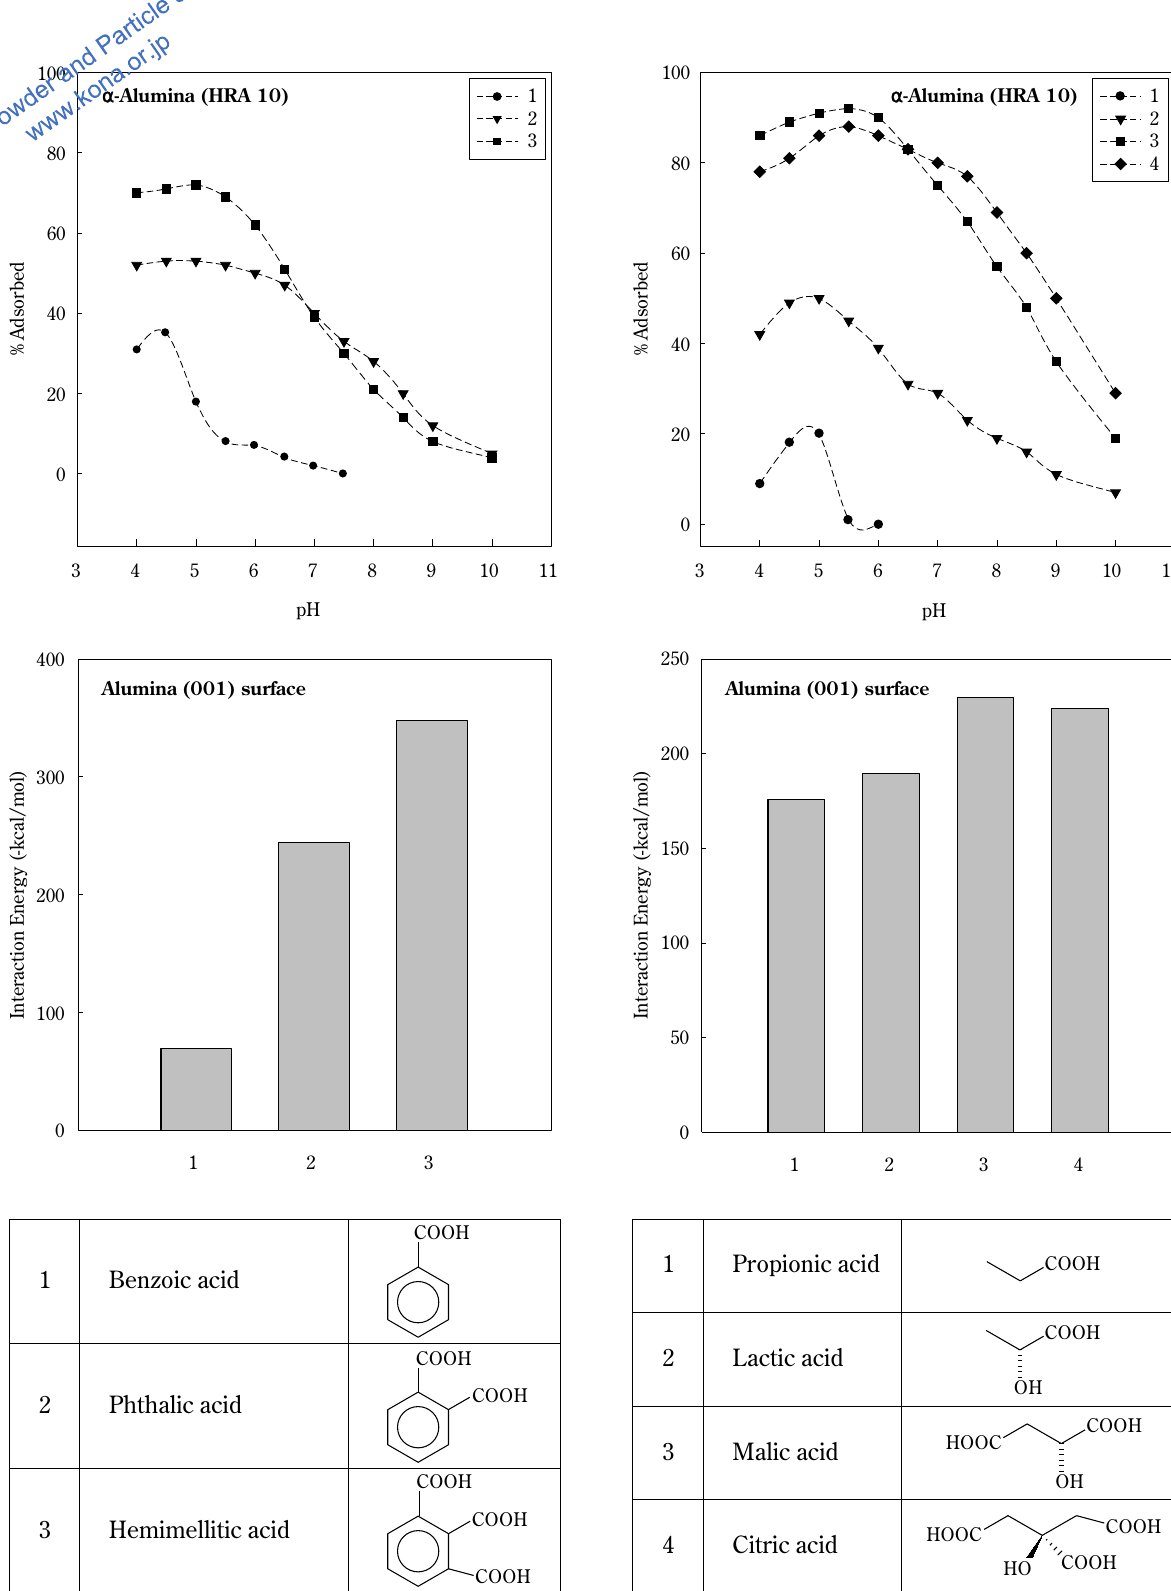
Fig. 5 (a) Adsorption curves for aliphatic carboxylic acids on α -alumina (data taken from Ref. [45]), (b) Theoretically computed interaction energies obtained using MD simula- tions in presence of